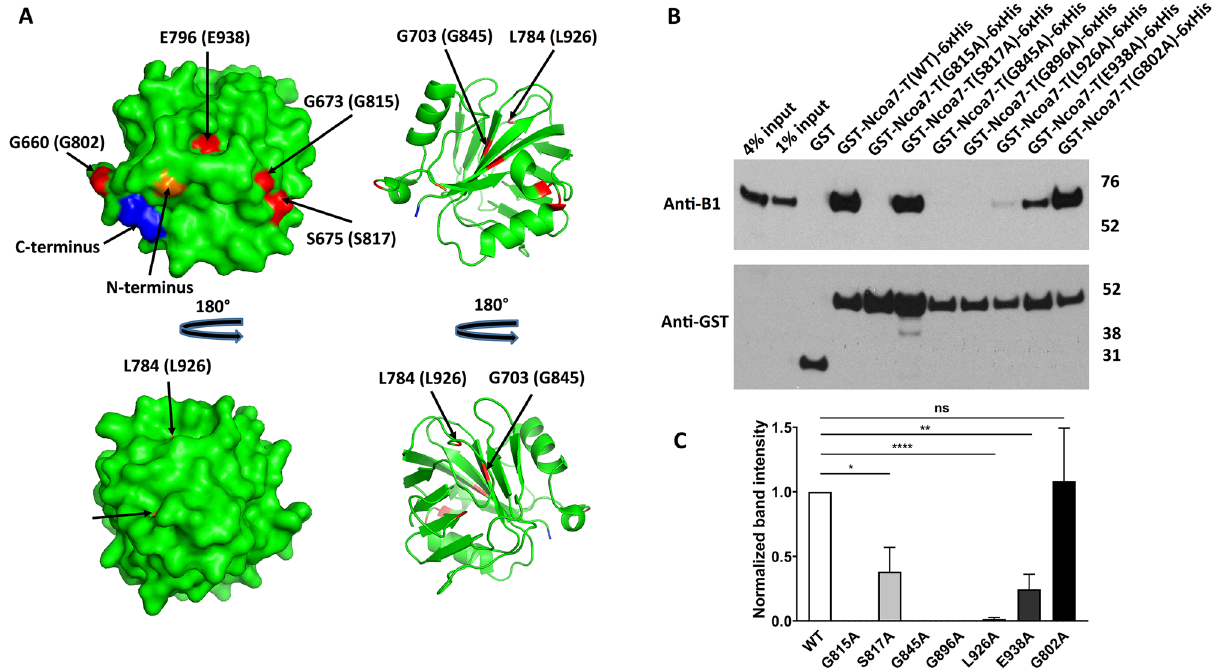
Figure 6. Alanine mutations of the evolutionarily conserved glycines, G815, G845 and G896, completely disrupt Ncoa7 TLDc domain interaction with the V-ATPase, while S817, L926 and E938 mutations show only partial disruption. Mutation of the non-conserved G802 residue (serving as a control) does not inhibit interaction. ( A ) Surface (left) and cartoon (right) representations of the zebrafish OXR2 TLDc domain, created with PyMol (Schrodinger, LLC. 2010. The PyMOL Molecular Graphics System, Version 2.0) using the crystal structure with the protein data bank identifier 4ACJ. The indicated zebrafish OXR2 residues G660, G673 and S675, which correspond to Ncoa7 residues G802, G815 and S817 (shown in parentheses) are exposed on the surface, while residues G703, G754, L784 and E796, which correspond to G845, G896, L926 and E938 in Ncoa7 (shown in parentheses) are buried within the protein. All these residues are colored in red. N-terminal G635 and C-terminal E801 amino acid residues are colored in orange and blue respectively, to better visualize the folding of zebrafish OXR2 TLDc domain. ( B ) Anti-B1 and anti-GST western blots of a representative GST pull-down assay, using the purified GST-tagged G802A, G815A, S817A, G845A, G896A, L926A and E938A mutants of the TLDc domain of Ncoa7 (775–943) as baits and kidney lysate, containing B1 subunit of V-ATPase, as a prey. GST only pull-down was used as a negative control; pull-down with GST-tagged wild-type (WT) TLDc domain of Ncoa7 (775–943) and the non-conserved G802A mutant were used as positive controls. Anti-GST blot was used as a loading control for comparison between samples. This experiment was repeated three times with similar results. ( C ) Quantification of western blotting results by band densitometry analysis. Anti-B1 band densities were divided by anti-GST band densities and then normalized relative to the WT Ncoa7 (775–943) B1/GST ratio. All values are means ± SE. *P = 0.0304; **P = 0.03; ****P = 0.0001, ns—non significant (P = 0.8494), by t-test. Note, that the detrimental effect of G815A, G845A and G896A mutations on interaction does not necessarily correlate with the glycine position in the three-dimensional structure of the protein: while G845 and G896 are buried within the protein, G815 is located on its surface ( A